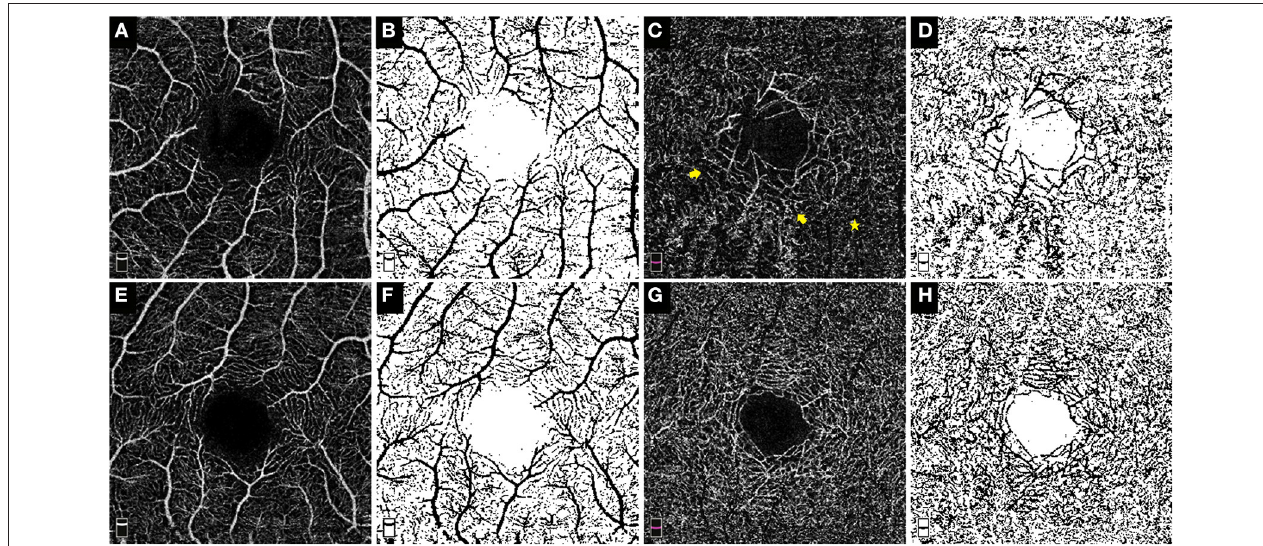
FIGURE 1 | OCTA enface images and the corresponding post-processed, standardized and binarized images. The OCTA enface images (3 × 3mm) of the SCP (A) and DCP (C) in eye with Coats’ disease and their binarized images in both plexuses (B,D) respectively. The OCTA enface images of the SCP (E) and DCP (G) in the contralateral eye and their binarized images in both plexuses [ (F,H) , respectively]. No obvious dilated and tortuous capillaries structures were detected in the SCP of this 10-year-old boy (A) ; in the DCP, the capillaries around the foveal avascular zone were obviously more dilated (the yellow arrow) in contrast to the surrounding capillaries (the yellow star), therefore, presence of microvascular abnormalities in the DCP of this eye was positive.